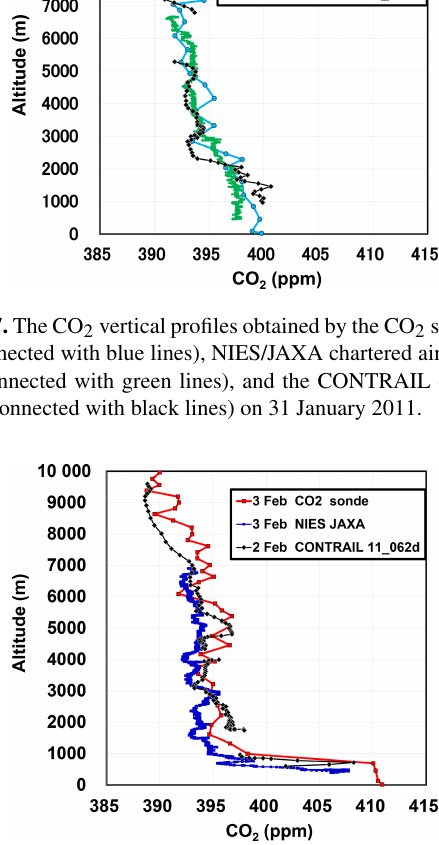
Figure 8. The CO 2 vertical profiles obtained by the CO 2 sonde (cir- cles connected with red lines), NIES/JAXA chartered aircraft data (dots connected with purple lines) on 3 February, and CONTRAIL data (diamonds connected with black lines) on 2 February